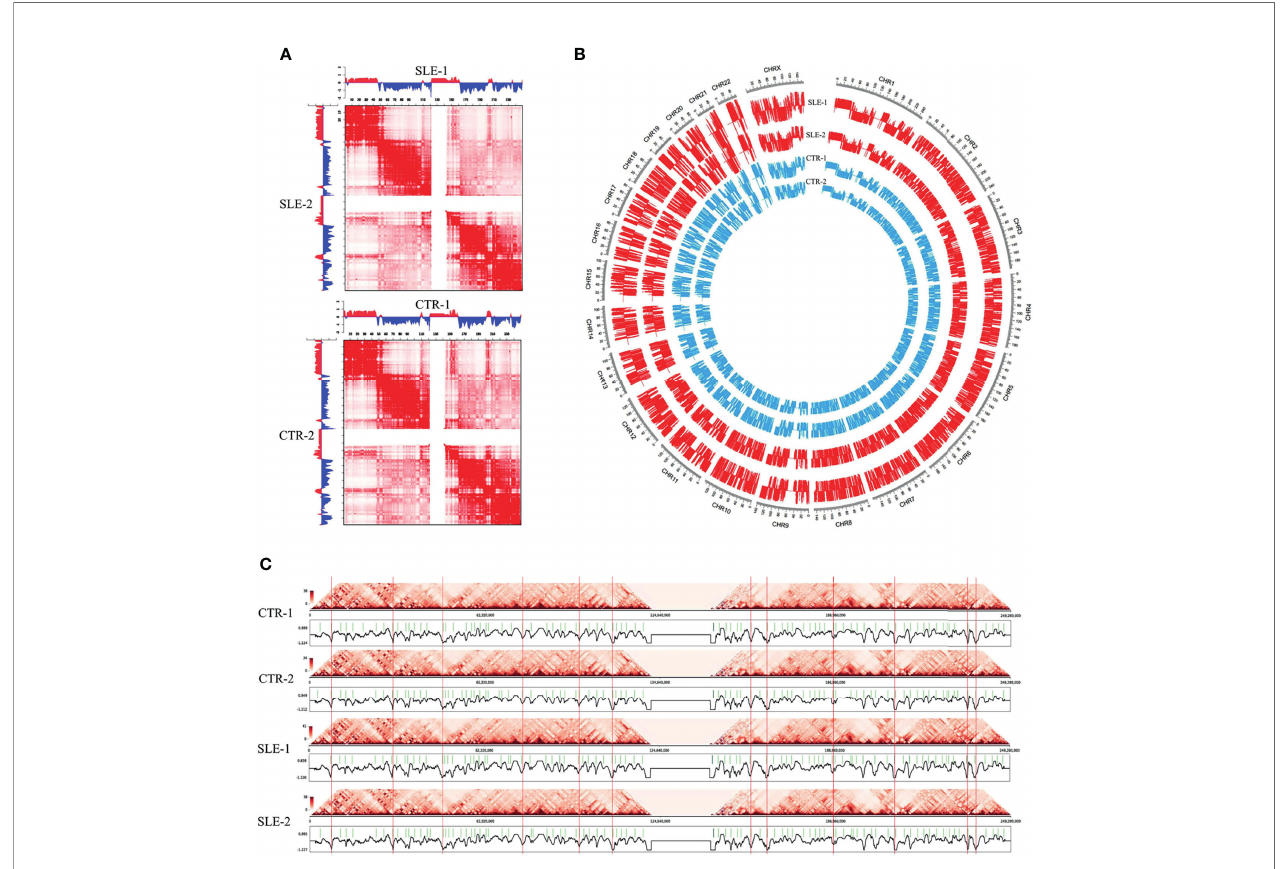
FIGURE 2 | Landscapes of primary monocytes. The different levels of Hi-C maps of four primary monocyte samples (SLE-1, SLE-2, CTR-1 and CTR-2). (A) Heatmaps of normalized chromatin interactions (100 kb bin) in chromosome 1. The upper and lower triangles represented different samples, and to be speci fi c, the fi rst heatmap represents SLE-1 (upper) and SLE-2 (lower), and the second heatmap represents CTR-1 (upper) and CTR-2 (lower). (B) The genome-wide A/B compartment distribution of the four samples. (C) The insulation scores and TAD boundaries in chromosome 1 among the four